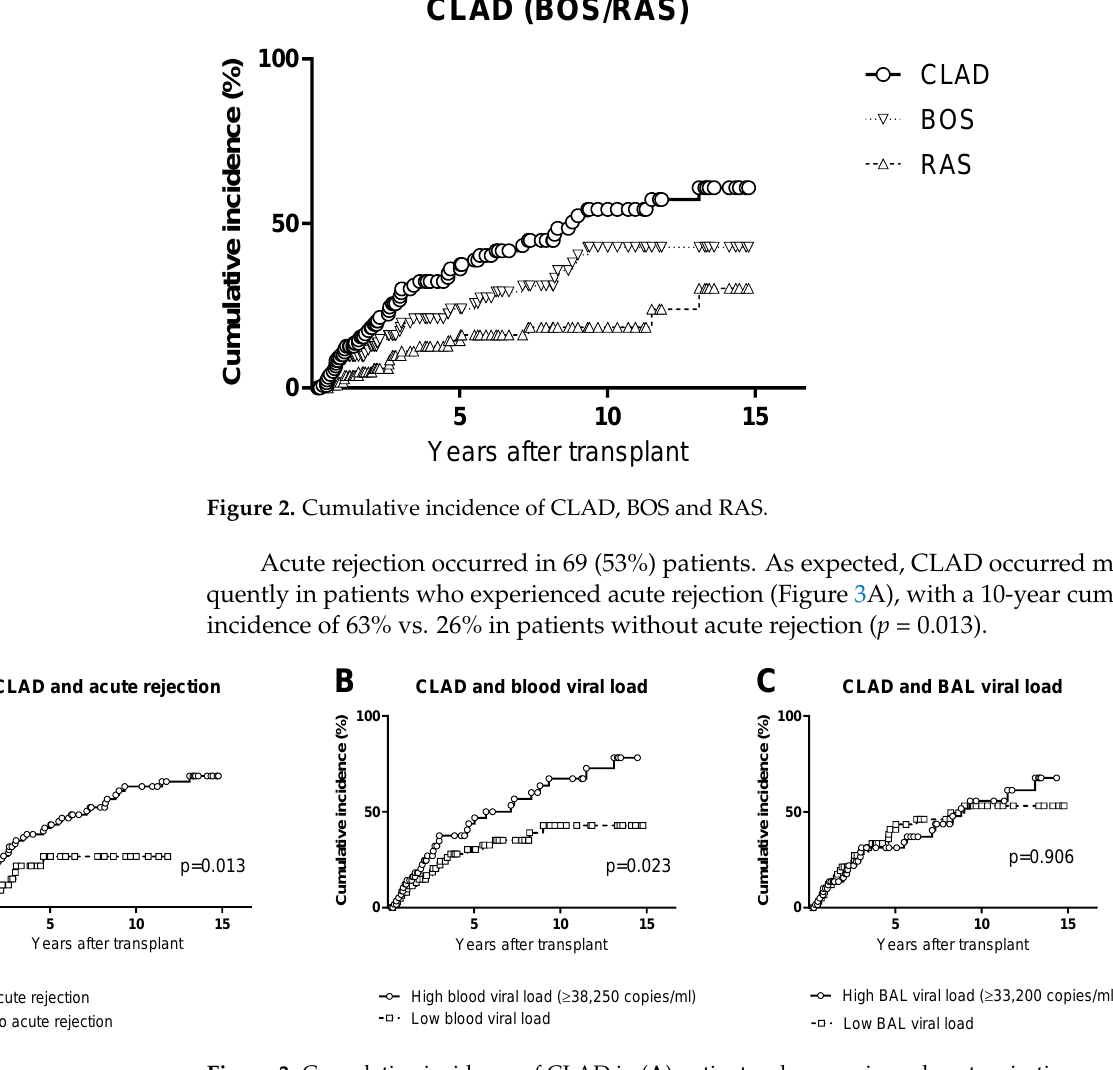
Figure 3. Cumulative incidence of CLAD in ( A ) patients who experienced acute rejection or no acute rejection; ( B ) patients who developed a CMV load in the blood above or below the median level; ( C ) patients who developed a CMV load in the BAL above or below the median level. The potential association between the cumulative incidence of CLAD and the level of CMV infection in the blood and BAL was analysed. The cumulative incidence of CLAD was significantly higher ( p = 0.023) in patients with a high CMV load in the blood (i.e., above the median value) but was not significantly different in patients with a high or low CMV load in the BAL (Figure